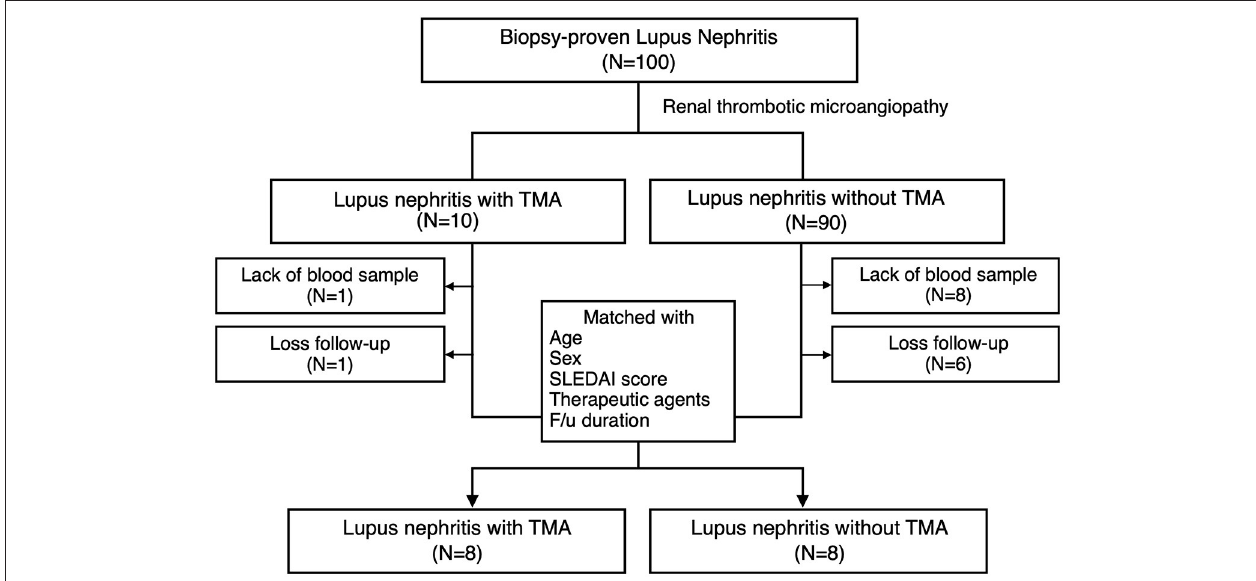
FIGURE 1 | Patient enrollment. Inclusion criteria of lupus nephritis patients with and without thrombotic microangiopathy and the design of the study.